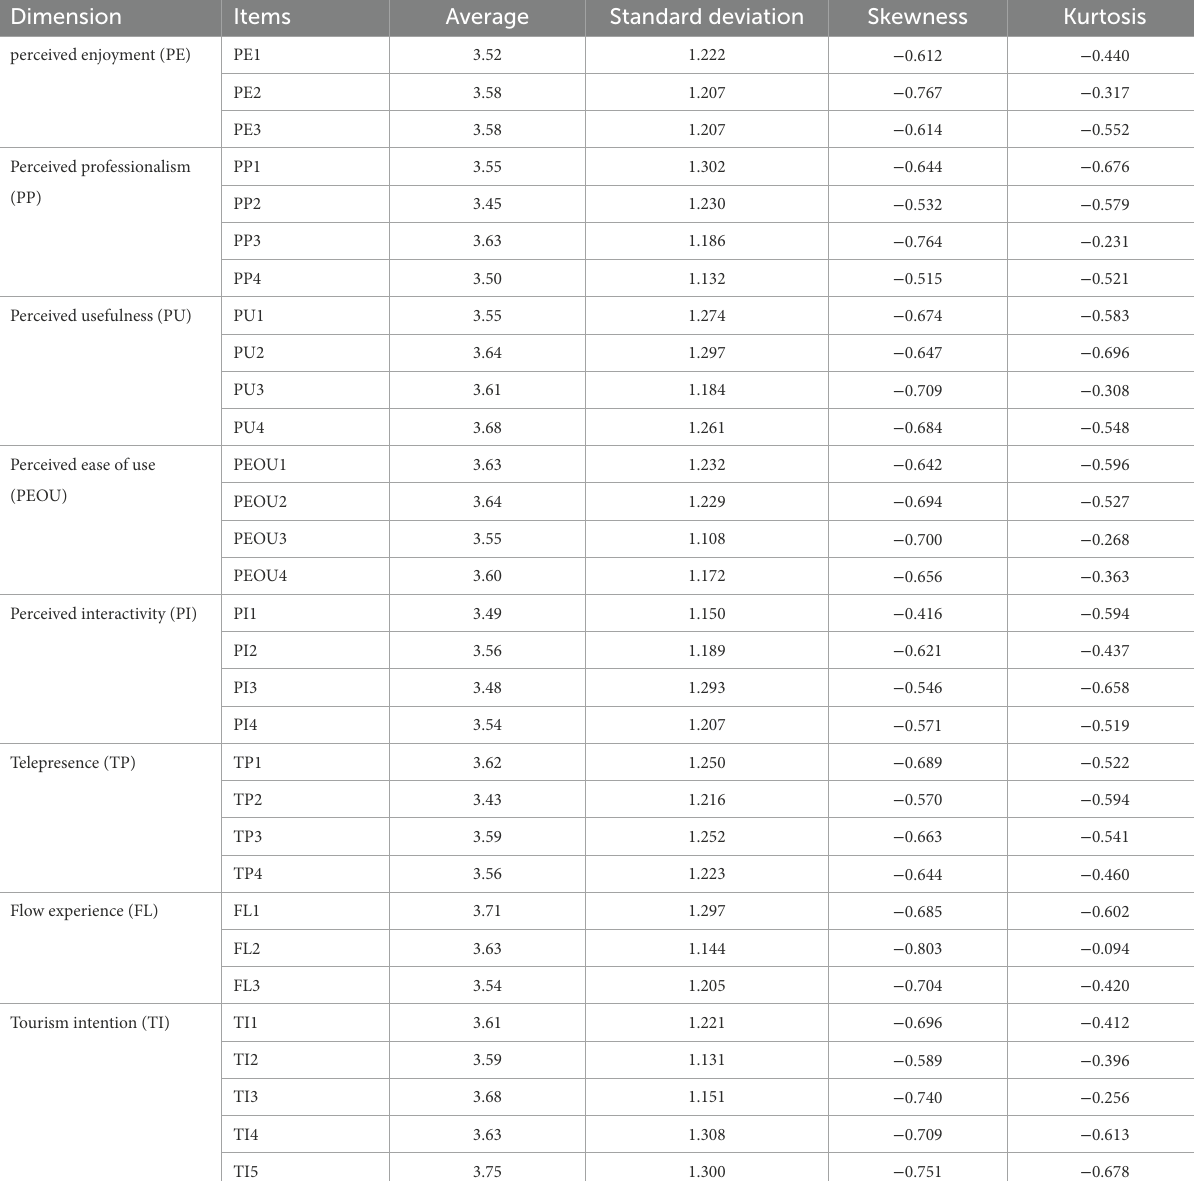
TABLE 3 Test of normal distribution of questionnaire.